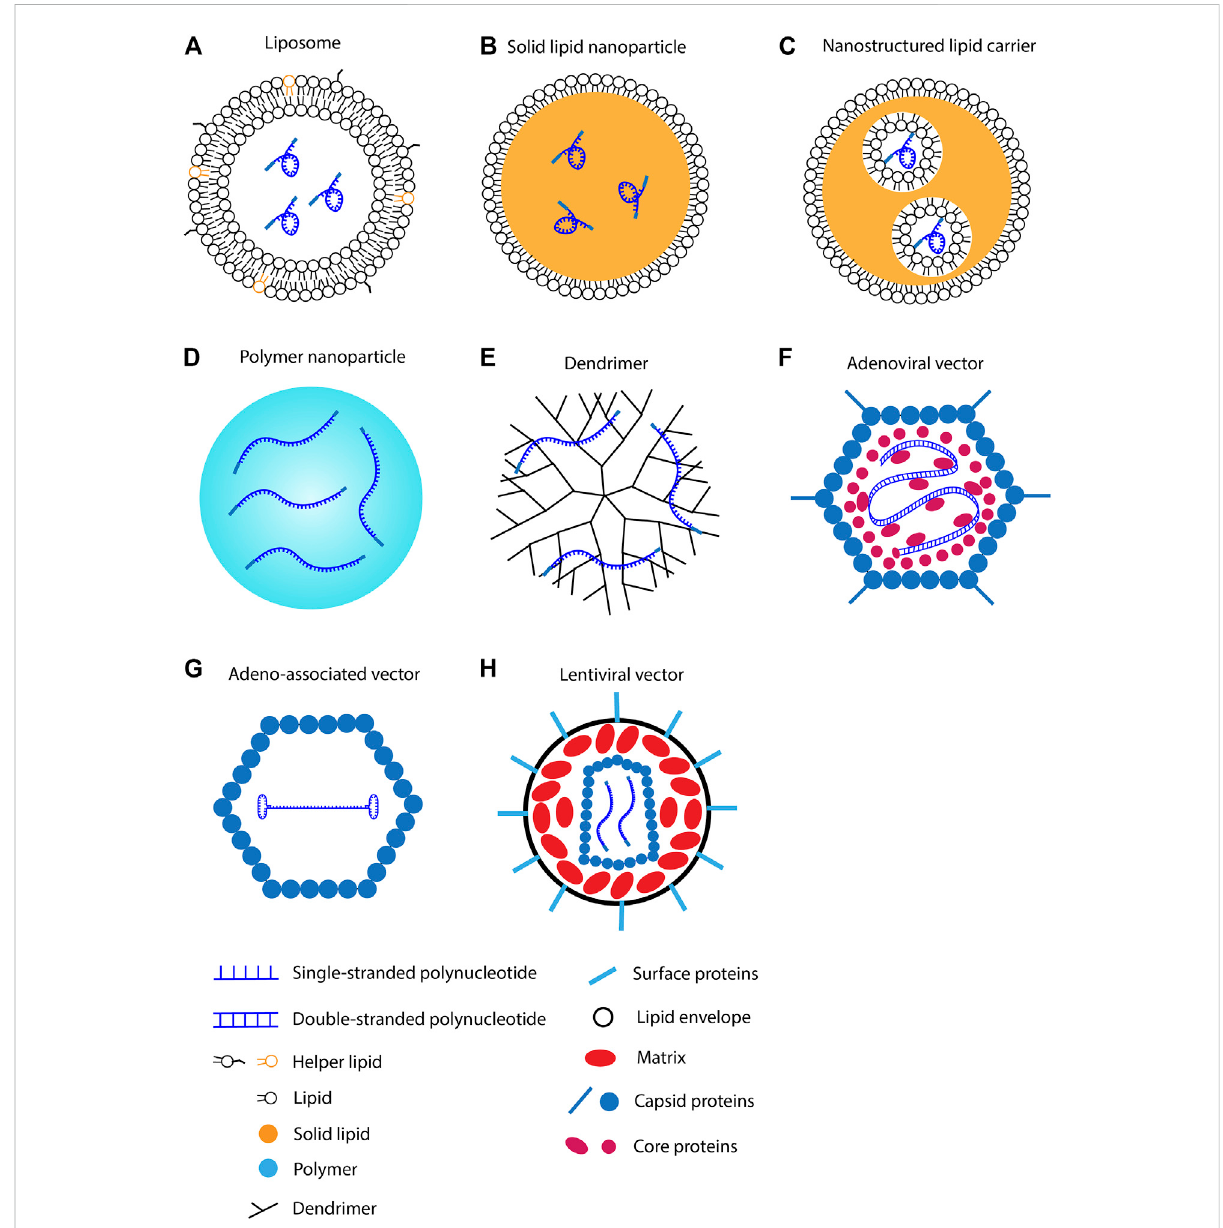
FIGURE 2 Methodsforpolynucleotideintracellulardelivery. (A) RNAinlipidnanoparticle. (B) RNAinsolidlipidnanoparticle. (C) RNAinnanostructuredlipid carrier. (D) RNA in polymer nanoparticle. (E) RNA in dendrimer. (F) Double-stranded DNA in adenoviral vector. (G) Single-stranded DNA in adeno- associated viral vector. (H) RNA in lentiviral